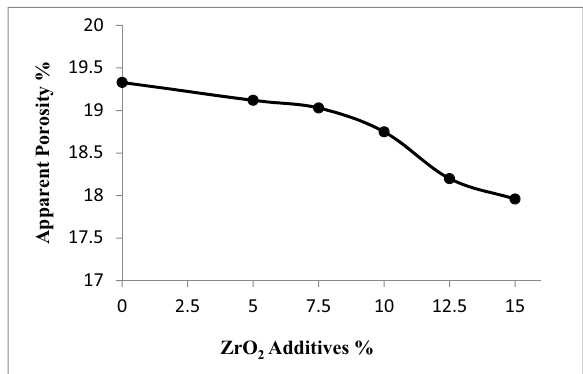
Figure 5: Apparent porosity for various ZrO 2 additions in refractory specimens.